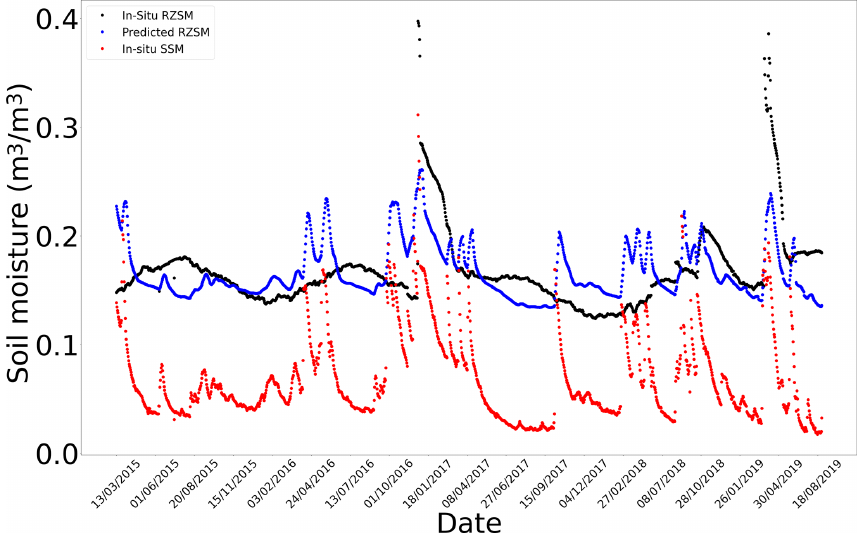
Figure G1. In situ SSM, in situ RZSM, and predicted RZSM series at station Barrage-162 (Tunisia) with model ANN_SSM.